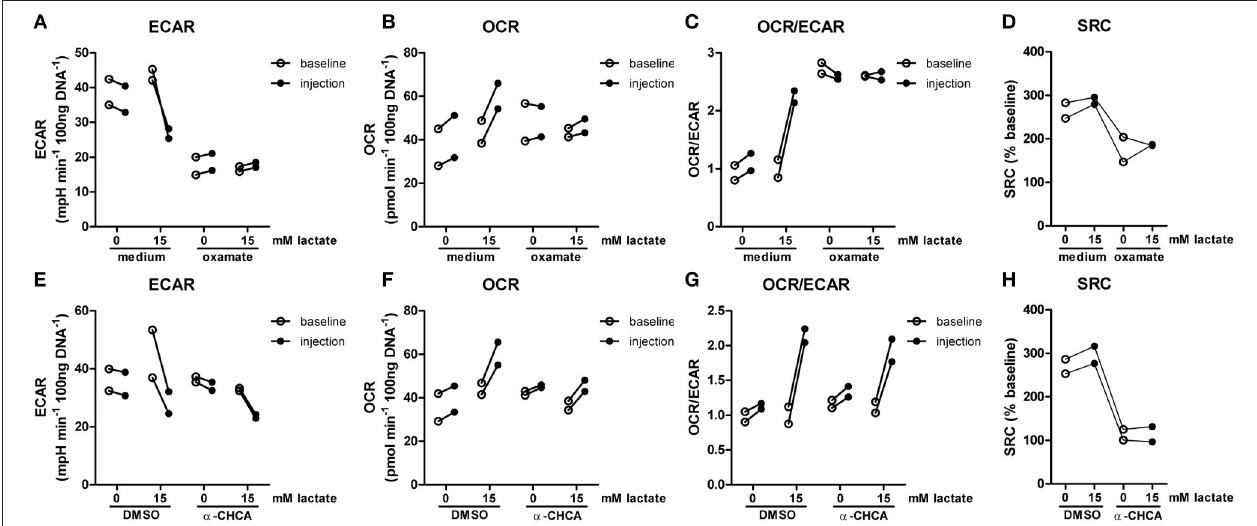
FIGURE 3 | LDH-inhibition abolishes acute effects of lactate on metabolism. CD14 + monocytes were pretreated for 1h with 40mM sodium oxamate and medium as a control (A–D) or with 0.5mM α -cyano-4-hydroxycinnamic acid ( α -CHCA) and DMSO as a control (E–H) before cells were exposed to lactate and metabolism was assessed. Change of ECAR (A,E) OCR (B,F) OCR/ECAR (C,G) and SRC (D,H) in human CD14 + monocytes after exposure to lactate. Each dot represents one healthy individual. n = 2.